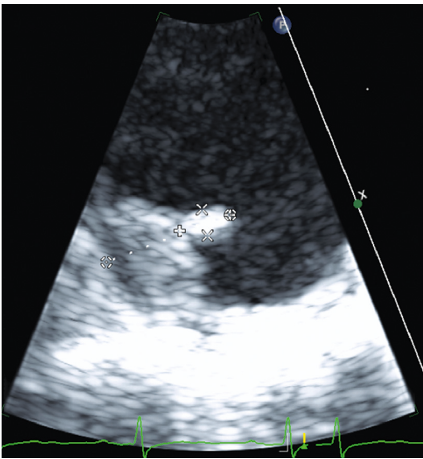
Figure 3: Short-axis TEE view with 12mm mobile aortic arch plaque.